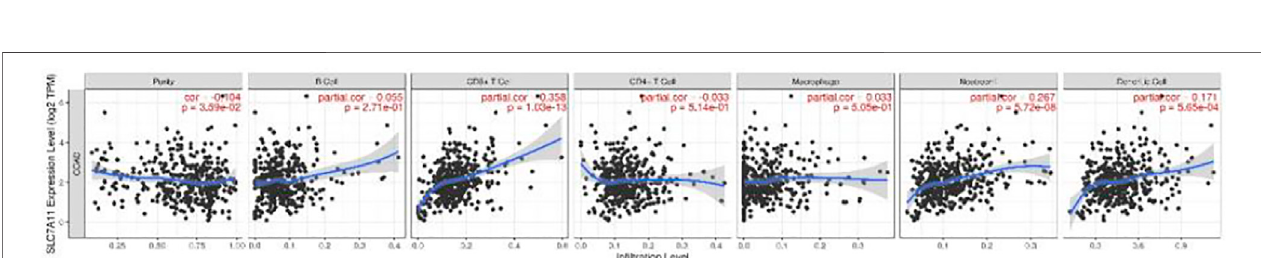
FIGURE 3 | Correlation of SLC7A11 expression with immune cell-in fi ltrated in COAD.